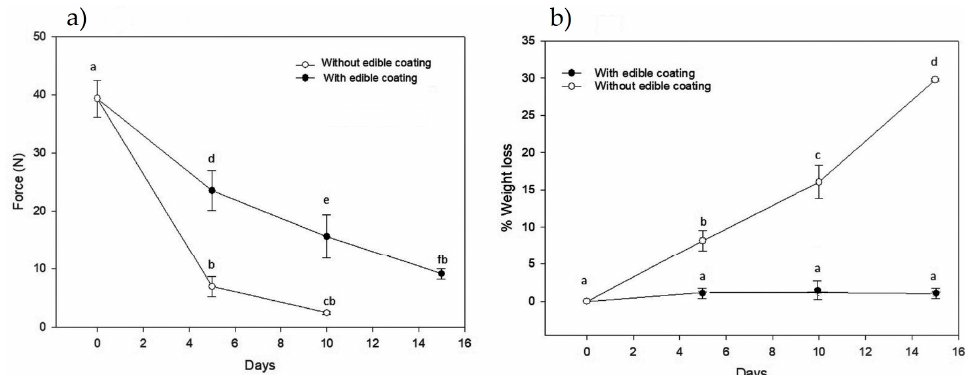
Figure 2. Physical changes during the ripening of papaya with and without coating during storage at room temperature: ( a ) papaya pulp firmness; ( b ) weight loss. a–f: used on top of reported values, indicate that if the same letter appears at different times, the values compared are not significantly different ( p > 0.05).